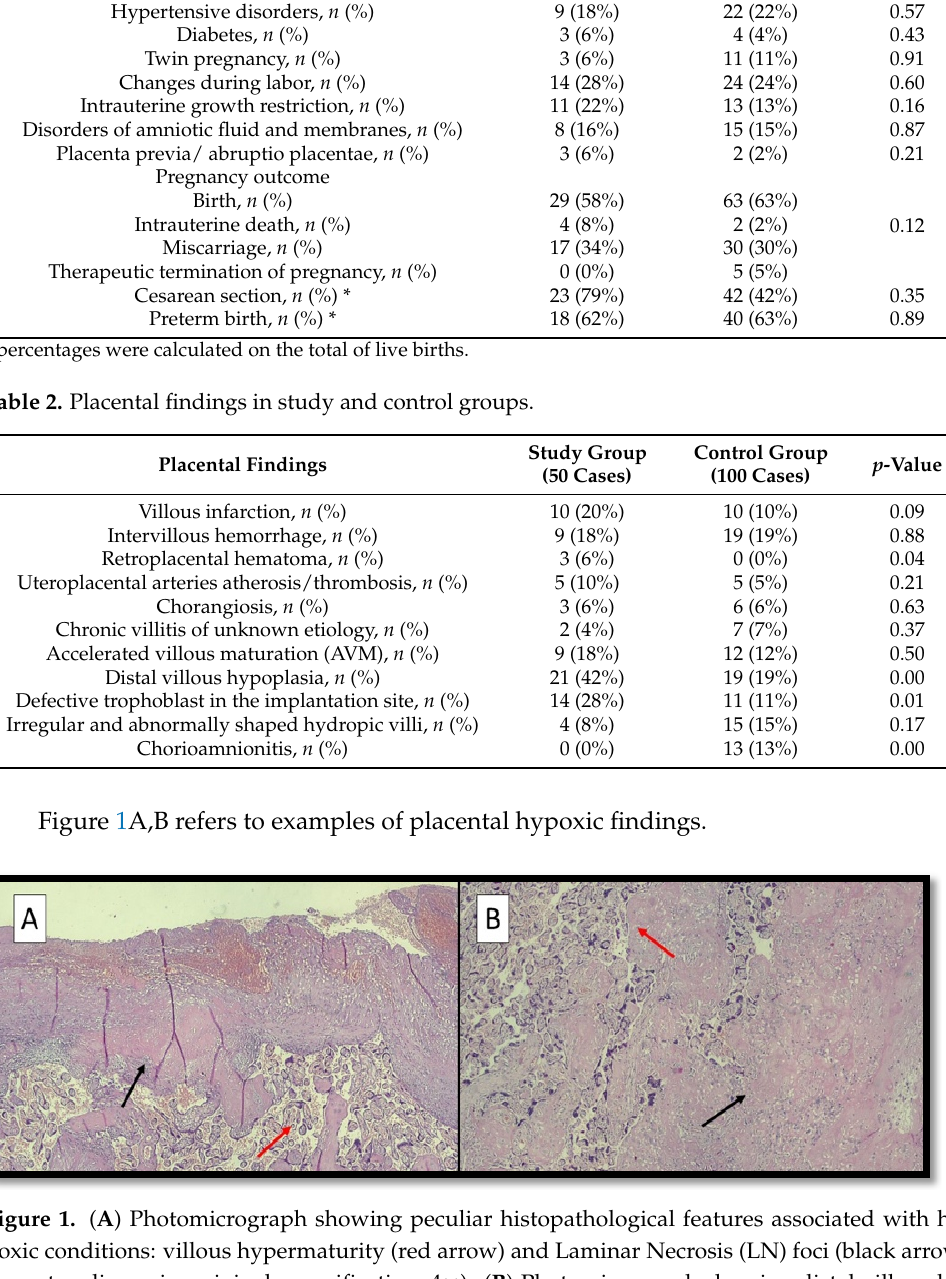
Table 3. Neonatal findings in study and control group.